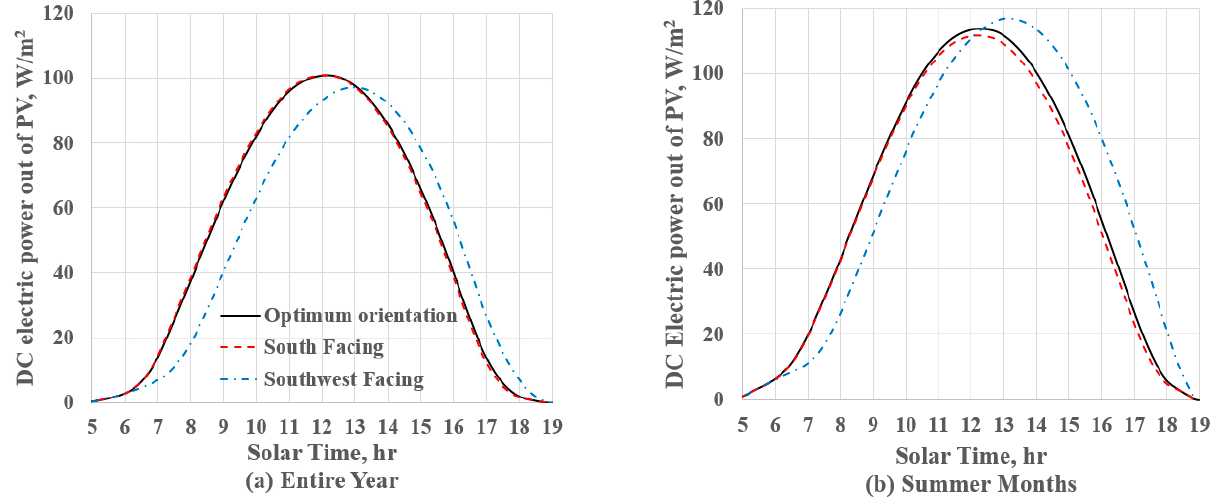
Figure 9. Average daily DC power generation for Los Angeles, California, USA. ( a ) For an entire year and ( b ) for summer months (June, July, and August). The optimum orientation and the south-facing panel generate almost the exact amount of power. For the entire year, the difference between the optimum orientation and the southwest-facing panel is more significant, close to 6%. For the summer months, however, the southwest-facing panel produces significantly higher power in the afternoon.